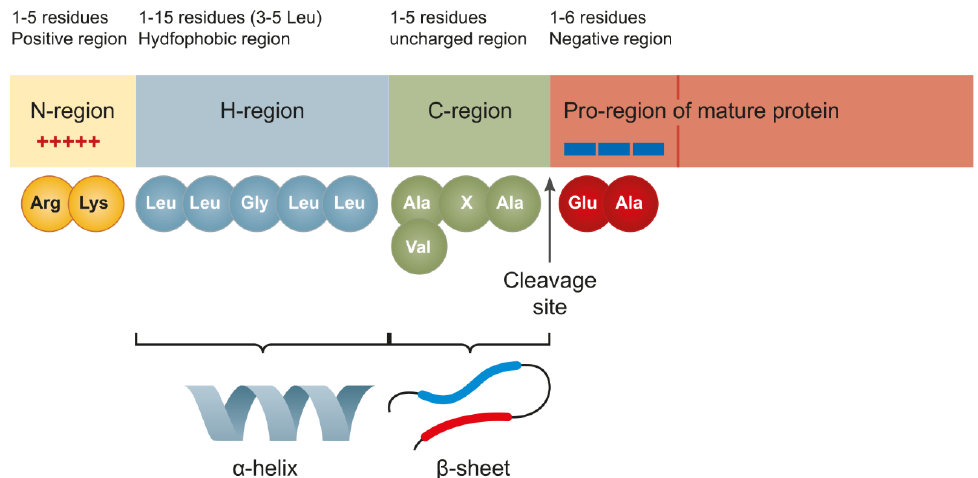
Figure 2. General structure of an SP. It is composed of three main parts: (1) an N-terminal region (a positively charged domain); (2) H-region (the hydrophobic core forming an α -helix); and (3) a C-terminal region (a cleavage site forming a β -sheet). The initial part of the protein, important to protein secretion, is referred to as the pro-region. Cleavage occurs within the AXA or VXA motif (adapted from [19], with permission).